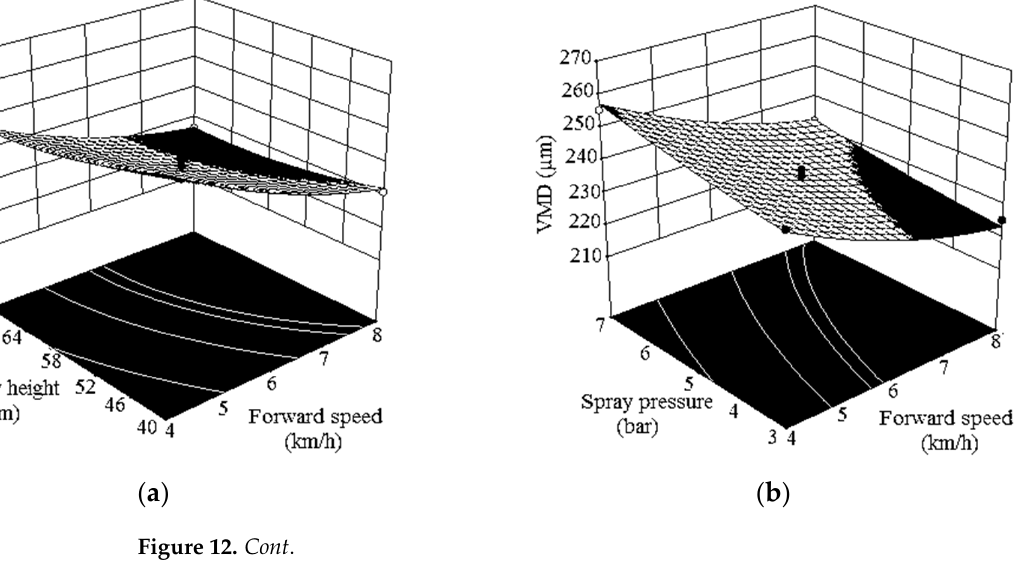
( c ) Figure 12. Three-dimensional surface map for VMD: ( a ) interaction effect of forward speed and spray height at 5 bar pressure; ( b ) interaction effect of forward speed and spray pressure at 55 cm height; ( c ) interaction effect of spray height and spray pressure at 6 km/h speed. 3.5. Validation of RSM Model The RSM model was validated by experimenting with the optimal condition for in- secticide and herbicide application (8 km/h, 70 cm, and 3 bar). The actual values of droplet density, coverage percentage, and VMD at optimized condition were 41.35 droplets/cm 2 , 21.10%, and 227.43 µm, respectively. The results of the predicted and actual response var- iables are given in Table 7. The prediction error [29] listed in Table 7 was calculated using Equation (5).   (%) = (  −  )   × 100 (5) As the predicted results found from regression equations agree with the actual re- sults and the prediction errors are less than ±10% [29], the developed models can be con- sidered as reliable for experimental results. Table 7. Optimal condition, predicted and actual value, at optimized spray condition. Response Variable Actual Value Predicted Value Prediction Error (%) Droplet density (droplets/cm 2 )